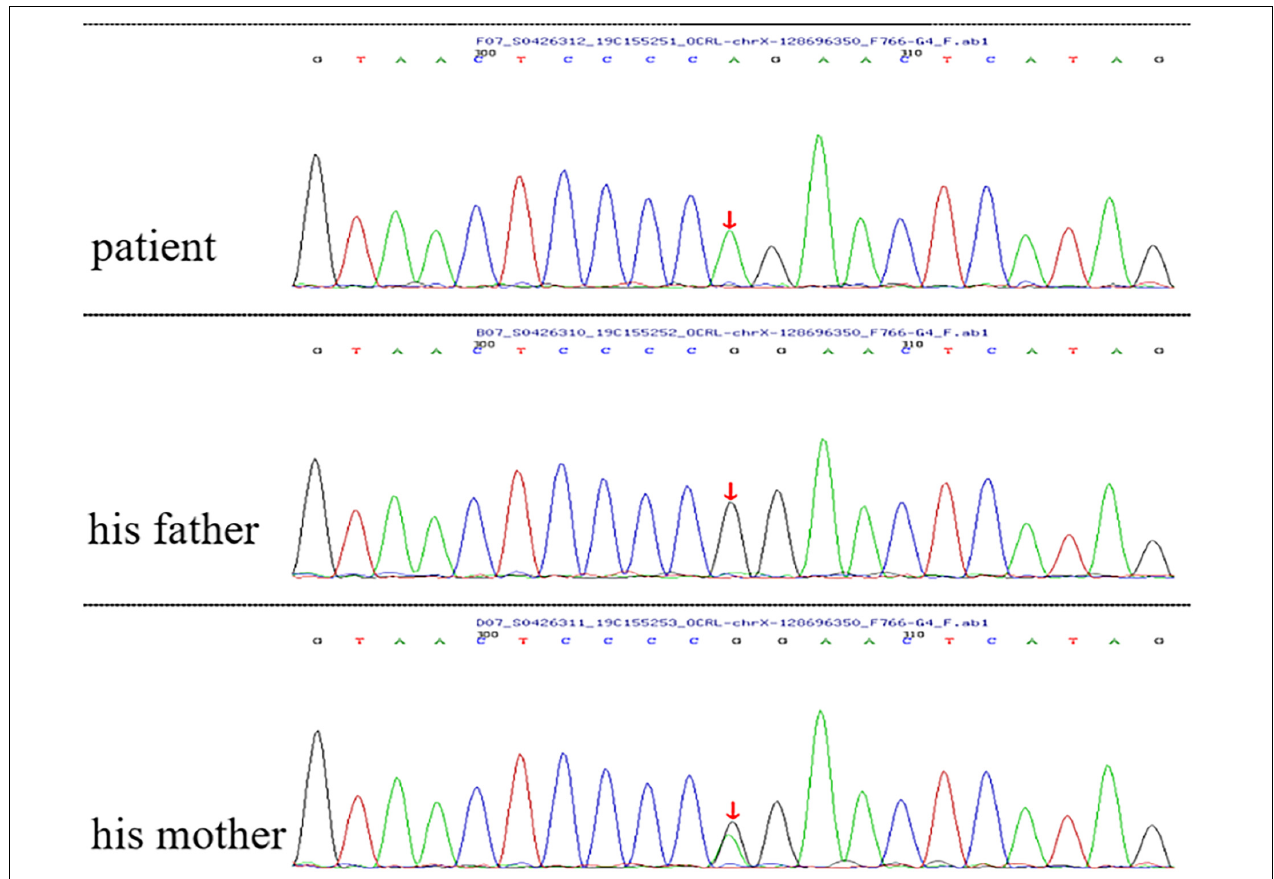
FIGURE 1 | Genetic analysis indicated that the boy had a splicing variant (c.940-11G > A) of the OCRL gene. His mother carried a heterozygous mutation, whereas no mutation was detected in his father. Red arrow indicates the site of the mutant